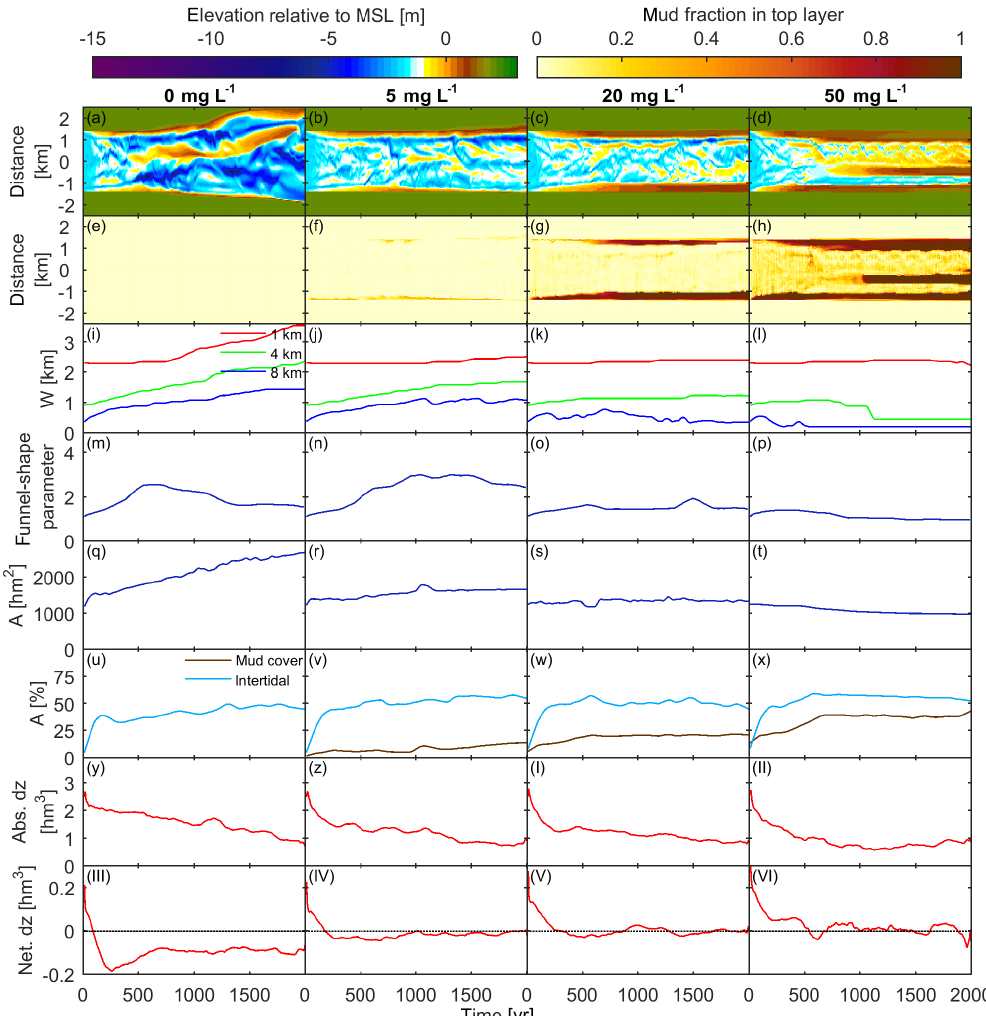
Figure 9. Hydrodynamics and morphodynamics over time for estuaries with different mud supply concentrations. From left to right (columns): model with only sand (03) and mud supply concentrations of 5 (10), 20 (default, 01) and 50mgL − 1 (09). (a–d) Bathymetry of the cross section at the mouth plotted over time, (e–h) mud fraction in the top layer of the cross section at the mouth, (i–l) estuary width at 1, 4 and 8km from the mouth, (m–p) funnel-shape parameter, (q–t) estuarine surface area, (u–x) intertidal area and mud in the bed relative to the total area, (y–II) absolute bed level change and (III–VI) net bed level